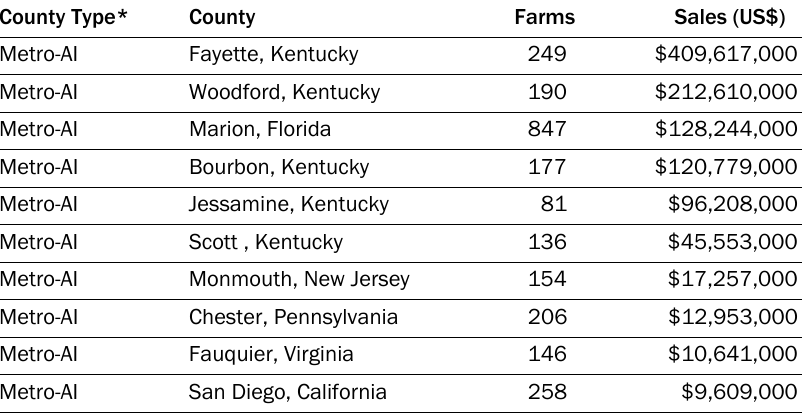
Table 3. Top 10 Horse Counties by Sales, 2007